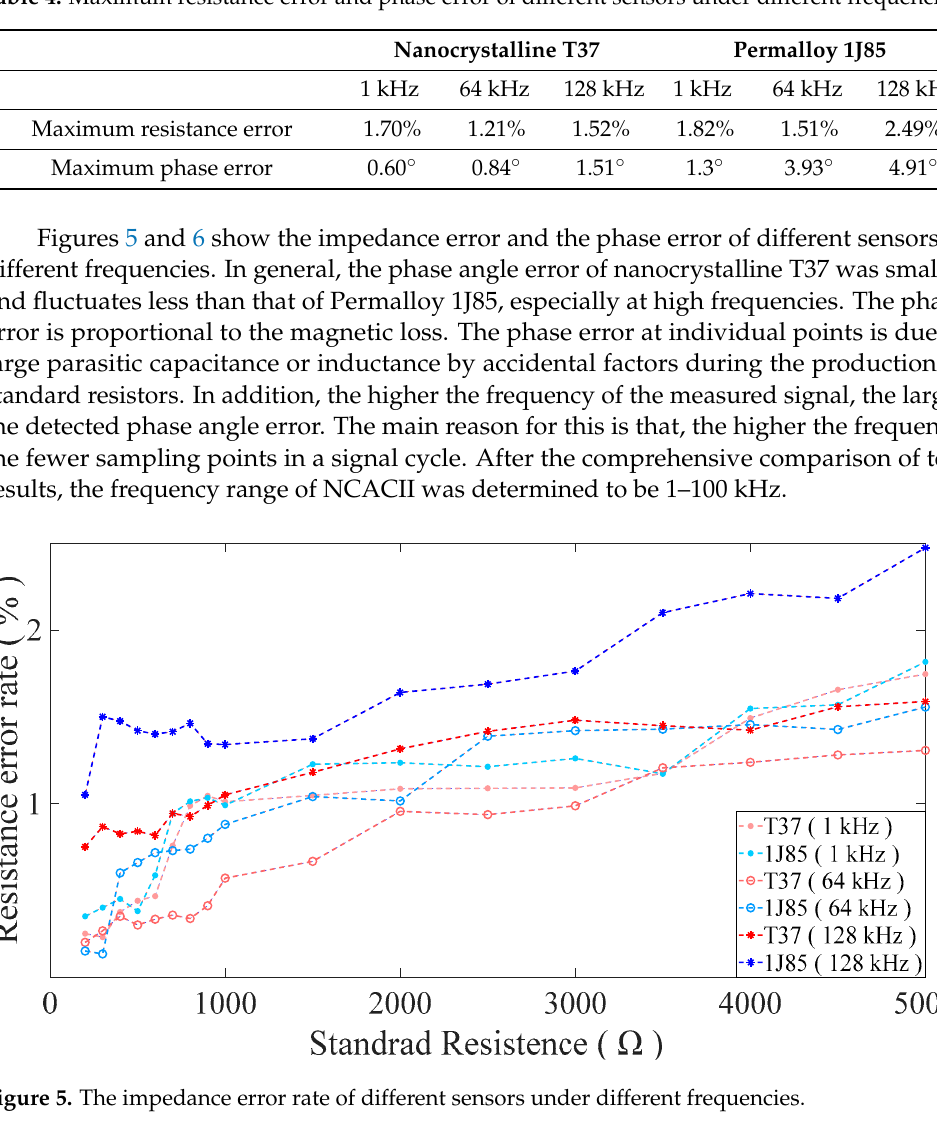
Table 4. Maximum resistance error and phase error of different sensors under different frequencies.